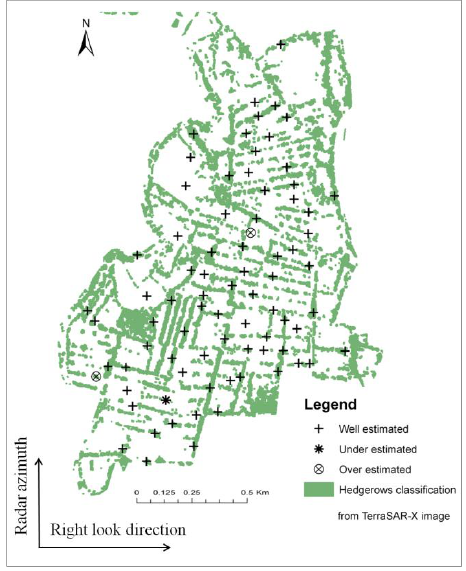
Figure 6. Map of the classified validation